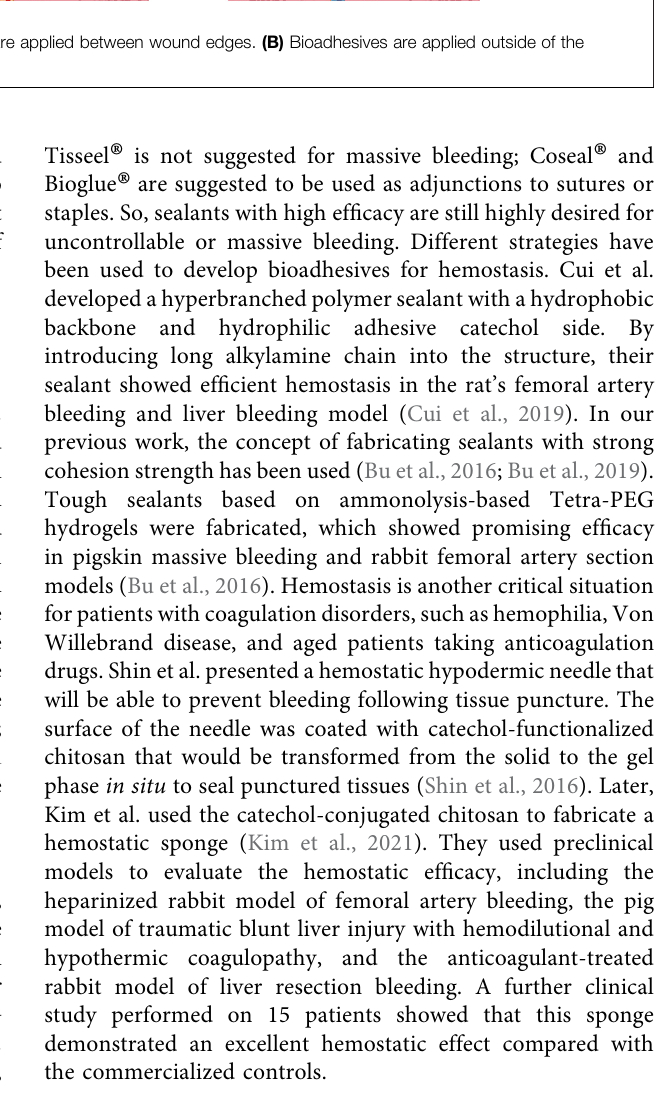
Frontiers in Bioengineering and Biotechnology |